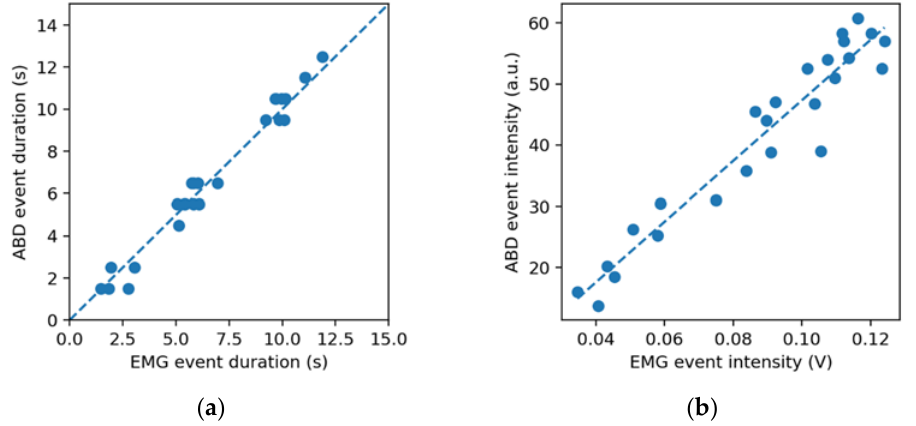
Figure 5. Data from a selected single subject, exhibiting good correlation between the two techniques. ( a ) Scatter plot of the event durations detected by EMG and ABD. The dashed line represents ideal agreement (y = x). ( b ) Scatter plot of event intensity detected by EMG (time averaged voltage) and ABD (value proportional to the time averaged sensor capacitance). The dashed line is the linear regression fit.